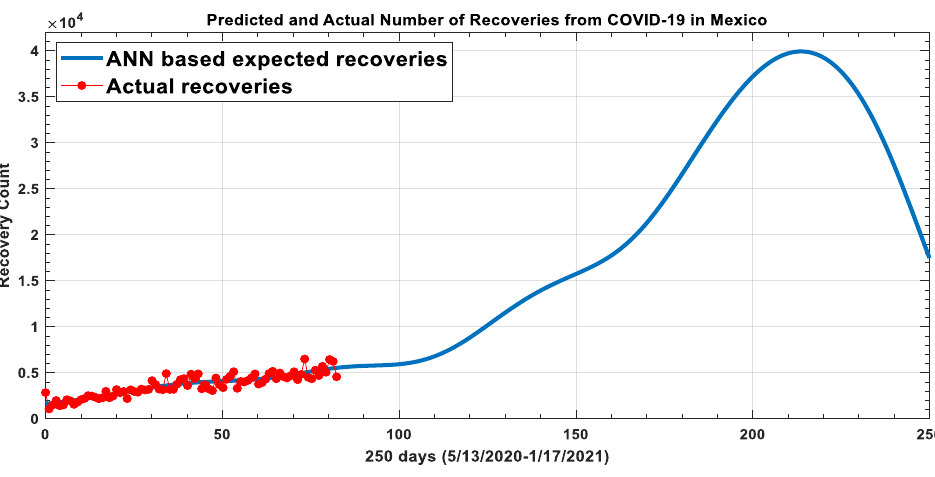
Figure 9. The training data and predicted data of COVID-19 recovered people in Mexico. Figure 9 shows the training data (in Red) and ANN-based predicted data (in Blue) of deaths from COVID-19 in Mexico, where the training data covers the duration from 7 April 2020, to 3 August 2020. In contrast, ANN-based expected number of deaths covers the period from 7 April 2020, to 12 December 2020. We have used the correlation confident between the testing data that covered the duration from 4 August 2020, to 22 November 2020, and the corresponding ANN values, as shown in Figure 10.